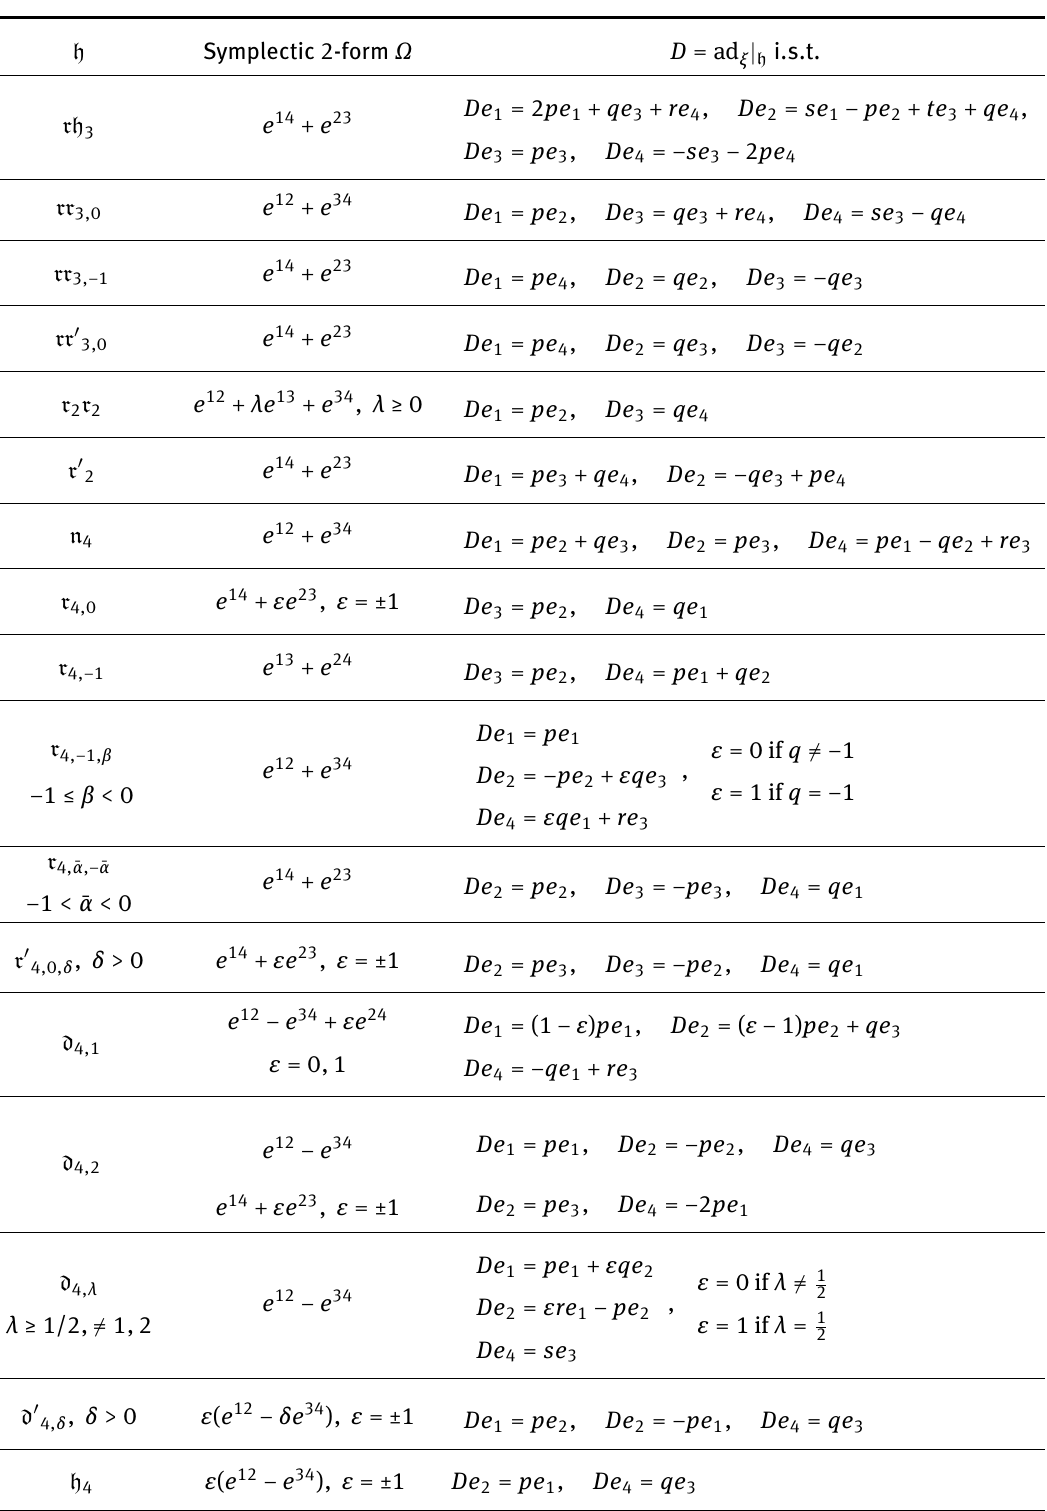
Table 1: 4 D symplectic Lie algebras giving rise to 5 D cosymplectic Lie algebras